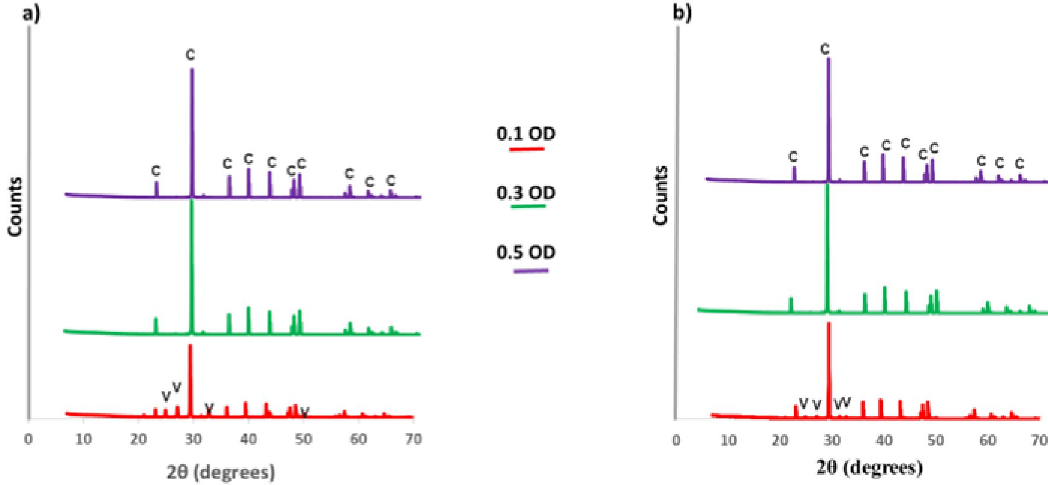
Fig 5. XRD spectrum of CaCO 3 . a) at 12 th hour, b) at the end of the process. c-calcite,